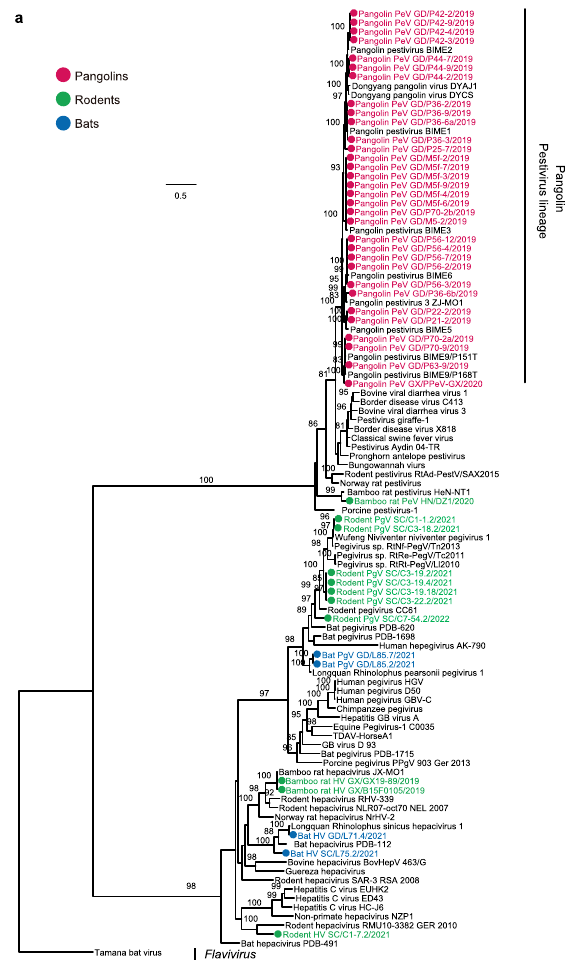
tree was rooted with Pestivirus K and BaPeV. Viruses detected in the different tissues of the pangolins are labeled in different colors. c Viral particles of pangolin pestivirus,growninVeroE6cellculture,seenbytransmissionelectronmicroscopy image. Scalebar, 2 μ m. The experiment wasperformed independently in